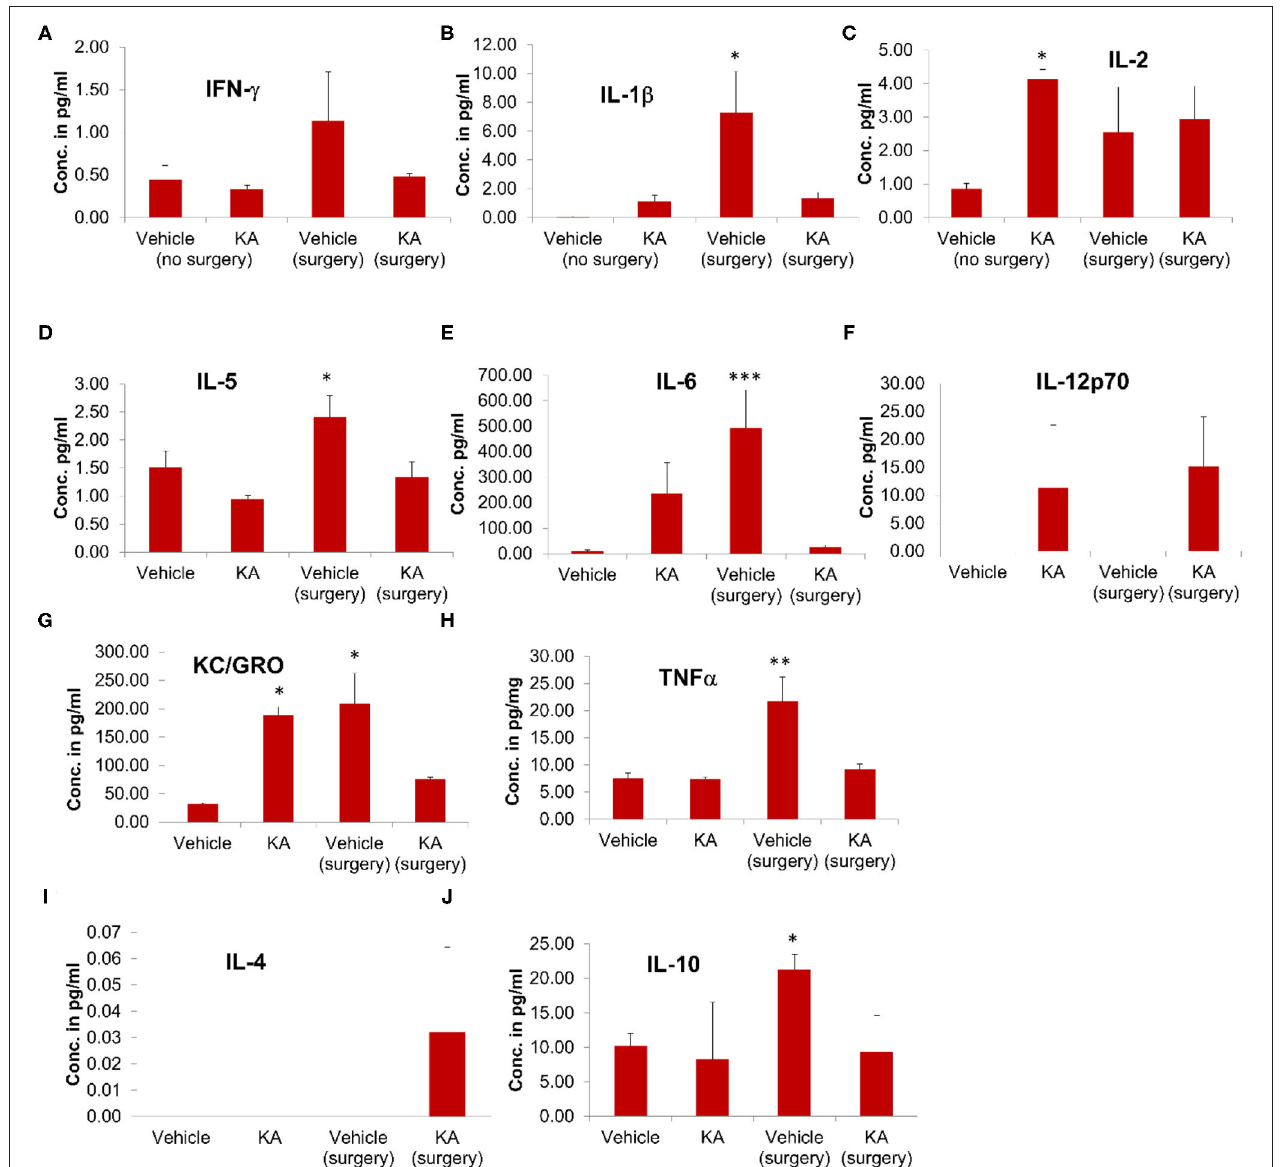
FIGURE 6 | The effects of the vehicle or KA treatment in the mice that had surgical implantation of EEG electrodes or without surgery on inflammatory cytokines in the plasma from the same animals that were used for proteomics (hippocampi) and multiplex assay (cerebral cortices). The following inflammatory cytokines were measured and represented in the graphs: (A) interferon- γ (IFN- γ ), (B) interleukin-1 β (IL-1 β ), (C) interleukin-2 (IL-2), (D) interleukin-5 (IL-5), (E) interleukin-6 (IL-6), (F) interleukin-12p70 (IL-12p70), (G) keratinocyte-derived cytokine/growth-related oncogene (KC-GRO), (H) tumor necrosis factor- α (TNF- α ), (I) interleukin-4 (IL-4), (J) interleukin-10 (IL-10). The data are expressed as the mean ( ± SEM) cytokine concentration in pg/ml of plasma. The values were compared statistically using one-way ANOVA with Tukey’s post-hoc test ( n = 4, * p < 0.05; ** p < 0.01; *** p <